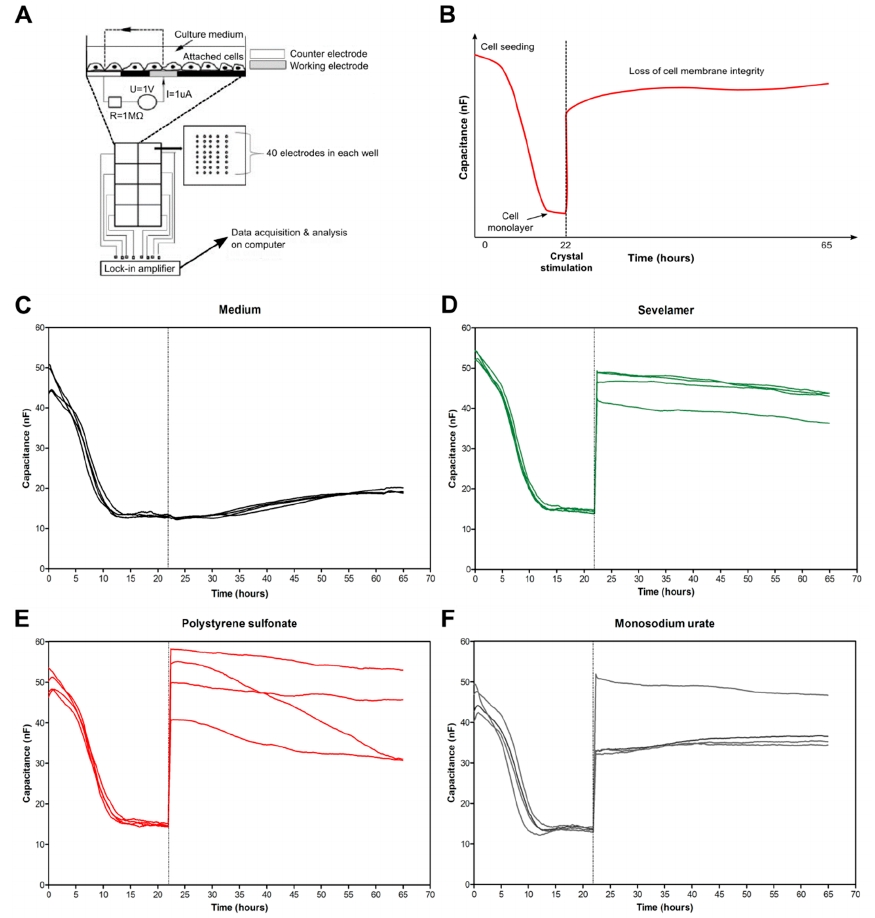
Figure 4. Crystals of ion-exchange resins induce intestinal epithelial barrier dysfunction. ( A ) Schematic of the electric cell-substrate impedance sensing (ECIS) working principle. Caco2 cells (30,000 cells / well) were grown on electrodes and covered in culture medium. The electrodes were connected to a lock-in amplifier and an AC signal was applied via a 1MX resistor to create a constant current. There are 40 electrodes in each well to measure the average capacitance in approximately 2000–4000 cells. Capacitance was applied at 16,000 Hz. ( B ) Schematic of the ECIS analysis. Cells were seeded on electrodes and when they were confluent after 22 h, the capacitance became stable. Afterwards, the medium was changed and the cells were stimulated with or without di ff erent crystal types for up to 65 h. Data are presented as normalized capacitance. ( C – F ) Images show the capacitance (nF) of Caco2 cells cultured in the medium alone ( C ), with sevelamer (1000 µ g / mL) ( D ), polystyrene sulfonate (1000 µ g / mL) ( E ), or monosodium urate (1000 µ g / mL, positive control) ( F ) crystals ( n =